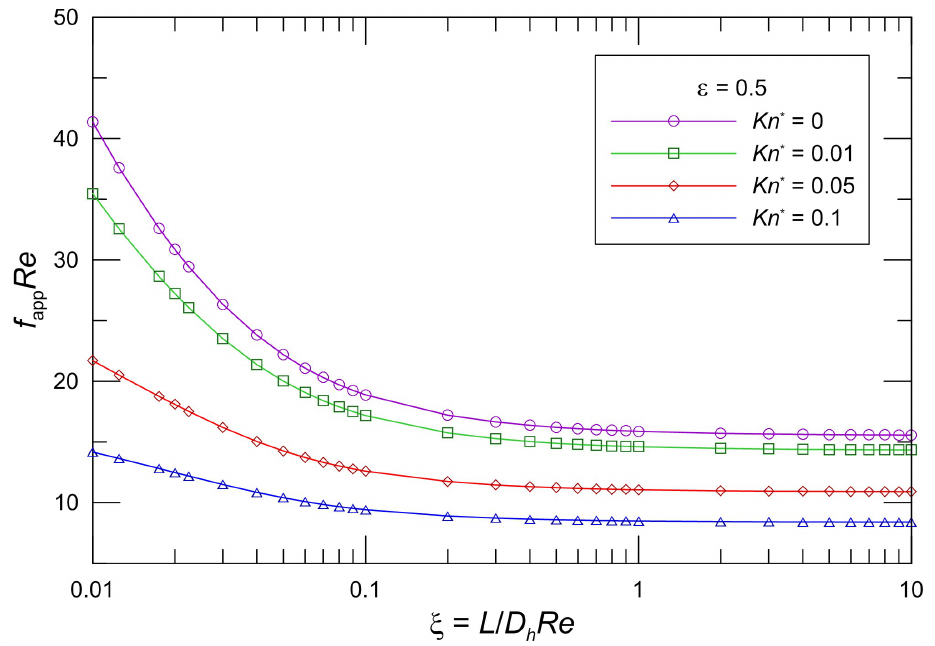
Figure 3. Effect of Kn * on f app Re for rectangular ducts ( ε =